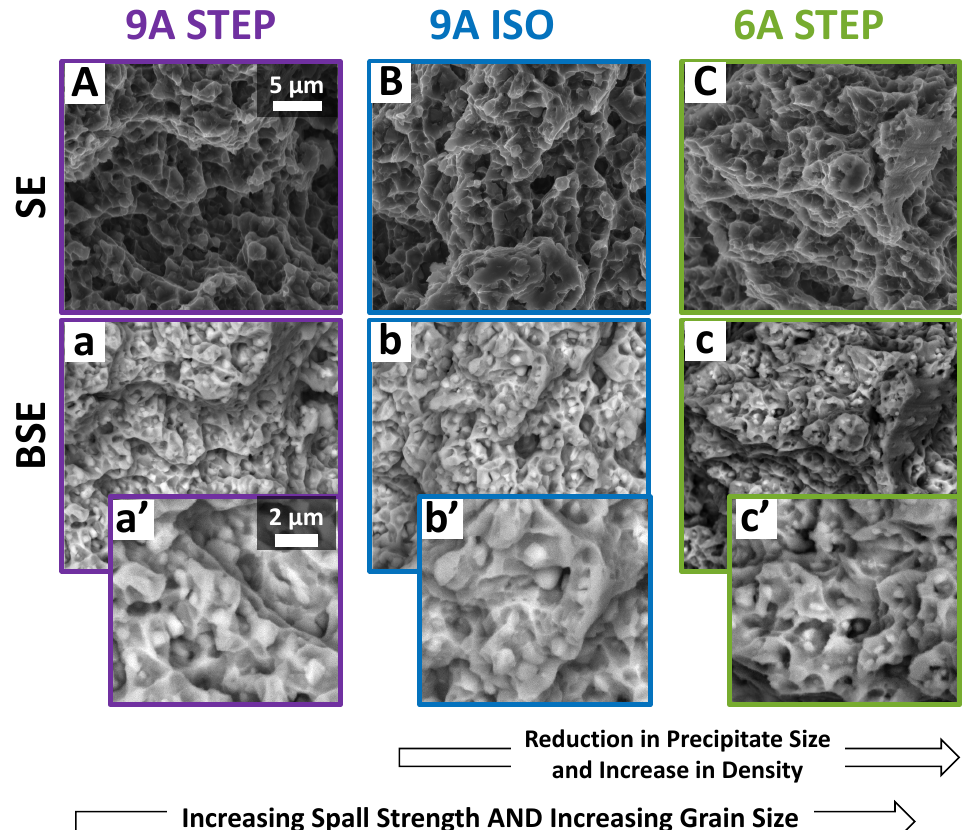
Figure 8. High-resolution SEM failure surface images of representative specimens from ECAE- processed sample sets. Each column depicts a specimen from a single sample set: (left) 9A STEP, (center) 9A ISO, and (right) 6A STEP. Micrographs are shown from ( A – C ) secondary electrons (SE), ( a – c ) backscattered electrons (BSE), and ( a’ – c’ ) magnified BSE. Frame ( A ) shows the scale bar for ( A – C ) and ( a – c ), and Frame ( a’ ) shows the scale bar for ( a’ – c’